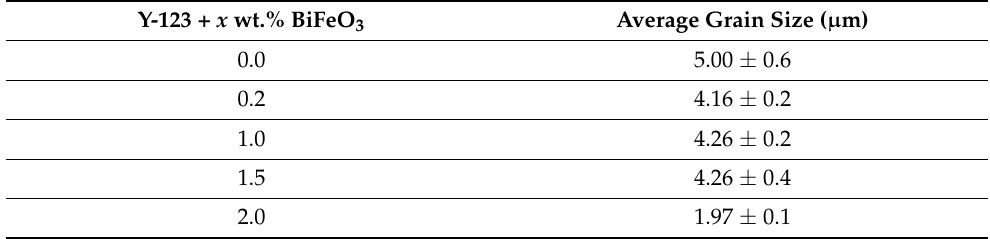
Figure 7. The FESEM micrographs (with a 5000× magnification) and grain size distribution for the surface Y-123 with different weight percentages of BiFeO 3 : ( a ) 0.0 wt.%, ( b ) 0.2 wt.%, ( c ) 1.0 wt.%, ( d ) 1.5 wt.%, and ( e ) 2.0 wt.%. Table 5. The average size for the Y-123 + x weight % of BiFeO 3.